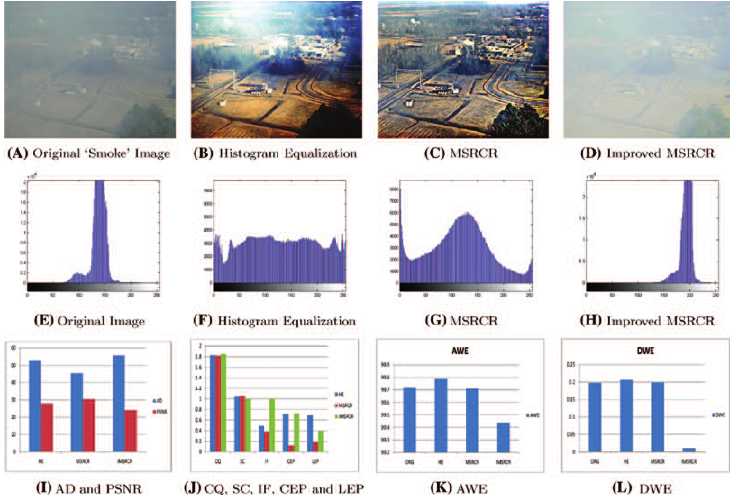
Figure 6. (Top) Image Enhancement Methods. (Middle) Histogram Plots: x -axis, Intensity Levels Ranging from 0 to 255; y -axis, Total Number of Pixels. (Bottom) Conventional Metrics and Proposed AWE and DWE Metrics. The “Smoke” Image has been Downloaded from